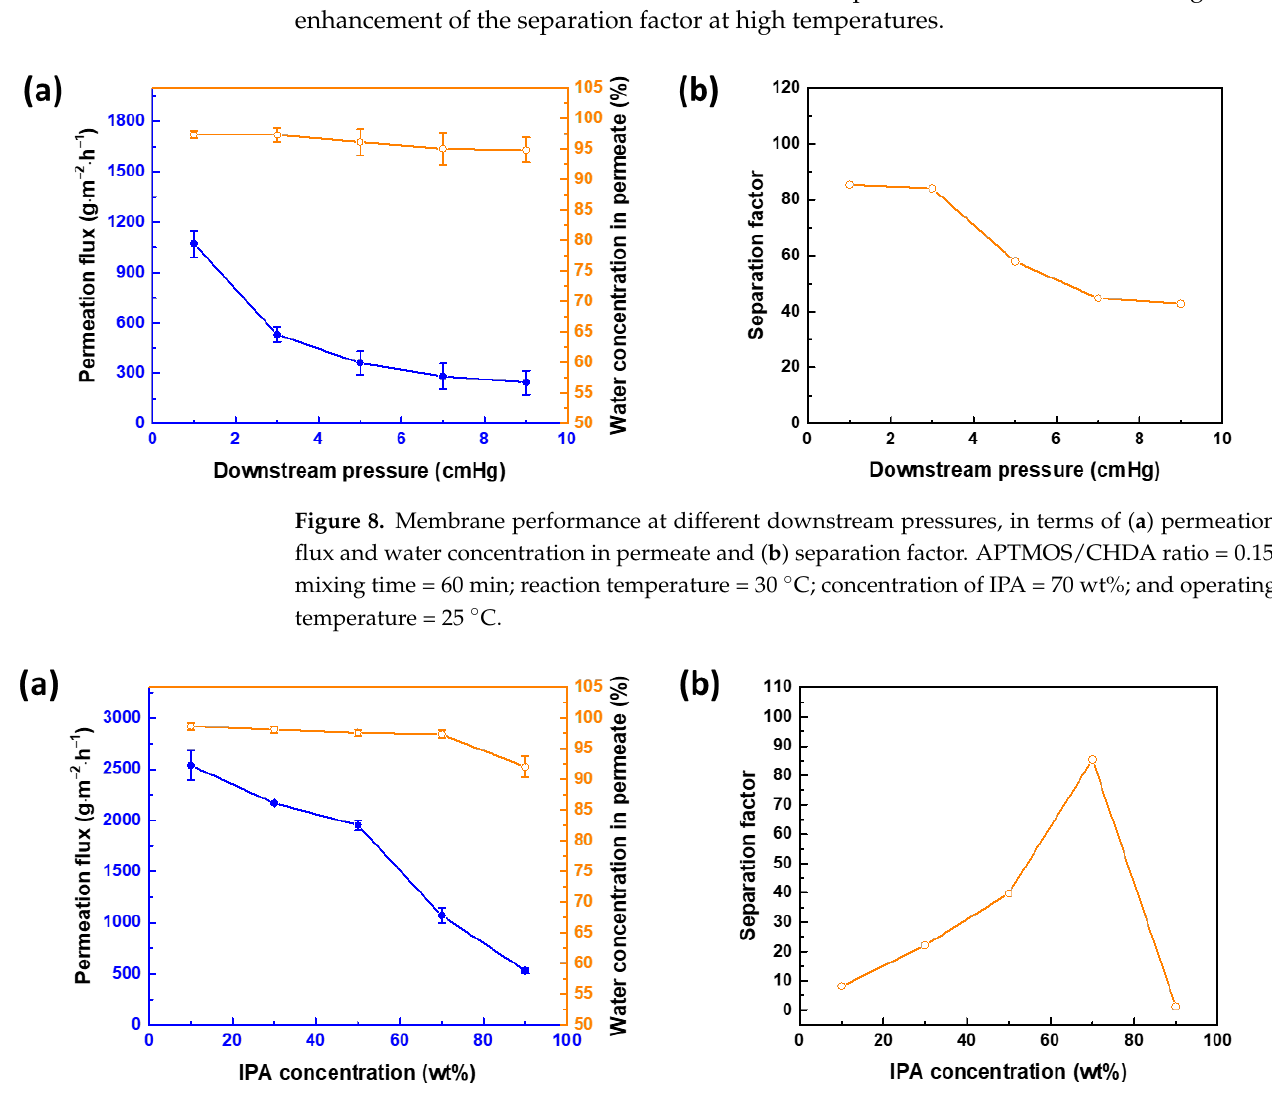
Figure 9. Membrane performance at different IPA concentrations in feed, in terms of ( a ) permeation flux and water concentration in permeate and ( b ) separation factor. APTMOS/CHDA ratio = 0.15; mixing time = 60 min; reaction temperature = 30 °C; downstream pressure = 1 mmHg; and operating temperature = 25 °C.